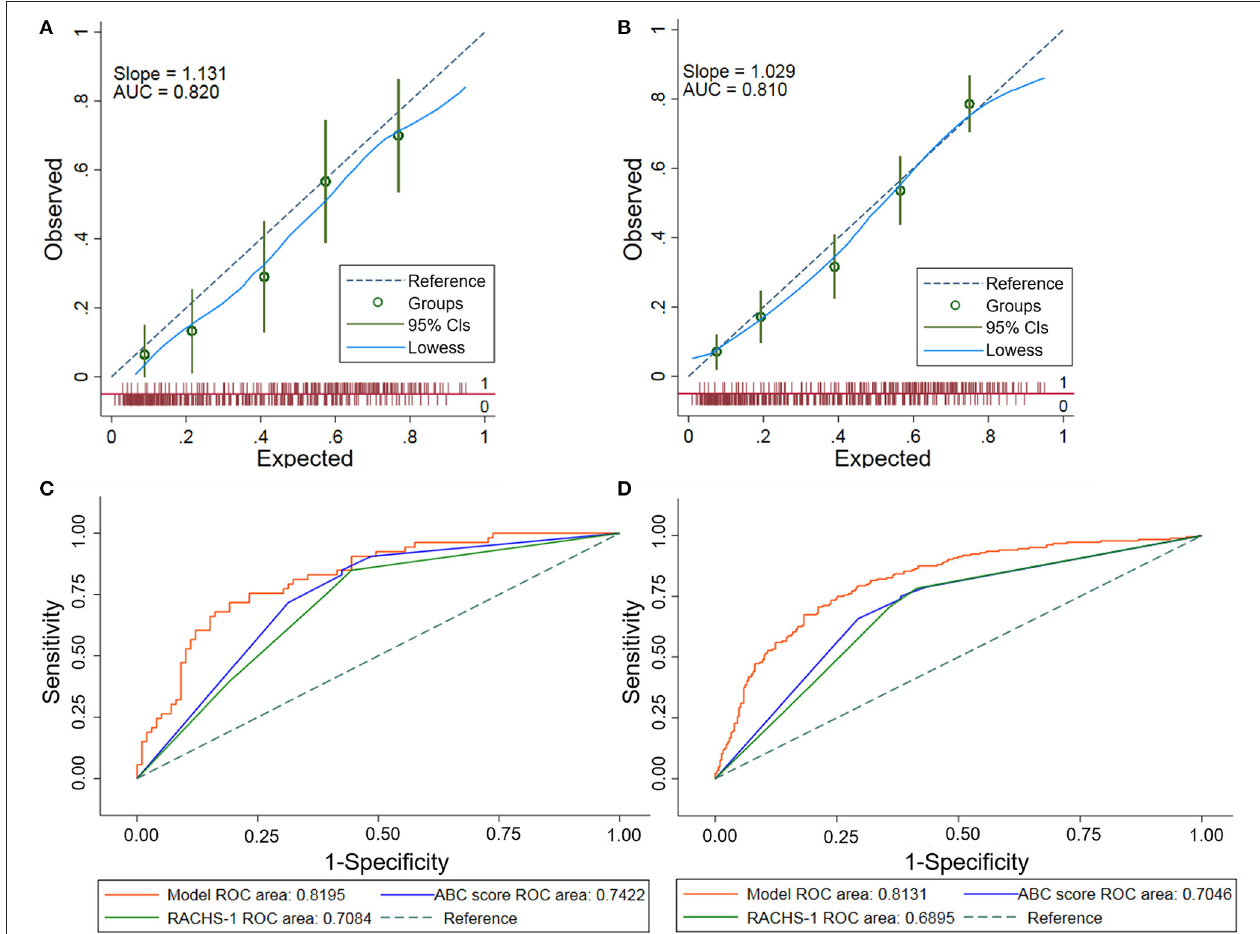
FIGURE 3 | Performance assessments of the Lasso model. (A) Calibration plot of the Lasso model in the validation set. The dashed diagonal line represents perfect calibration. Observed adverse events are shown with the corresponding 95% CIs. The x- axis is the predicted probability estimated by the model and the y- axis is the actual probability. (B) Calibration plot of the Lasso model in the overall population. There was a good agreement between the predicted and observed probabilities in the overall population. The dashed diagonal line represents perfect calibration. Observed adverse events are shown with the corresponding 95% CIs. (C) Receiver operating characteristic (ROC) curves comparing the Lasso model with the ABC score and the RACHS-1 in validation set. This comparison showed that the Lasso model outperformed the ABC score and the RACHS-1 in prediction of postoperative adverse events in the validation set ( p < 0.05). (D) Receiver operating characteristic (ROC) curves comparing the Lasso model with the ABC score and the RACHS-1 in the overall population. The Lasso model outperformed the ABC score and the RACHS-1 in prediction of postoperative adverse events in the overall population ( p < 0.001). Lasso, least absolute shrinkage and selection operator; ABC, Aristotle Basic Complexity; RACHS-1, Risk Adjustment for Congenital Heart